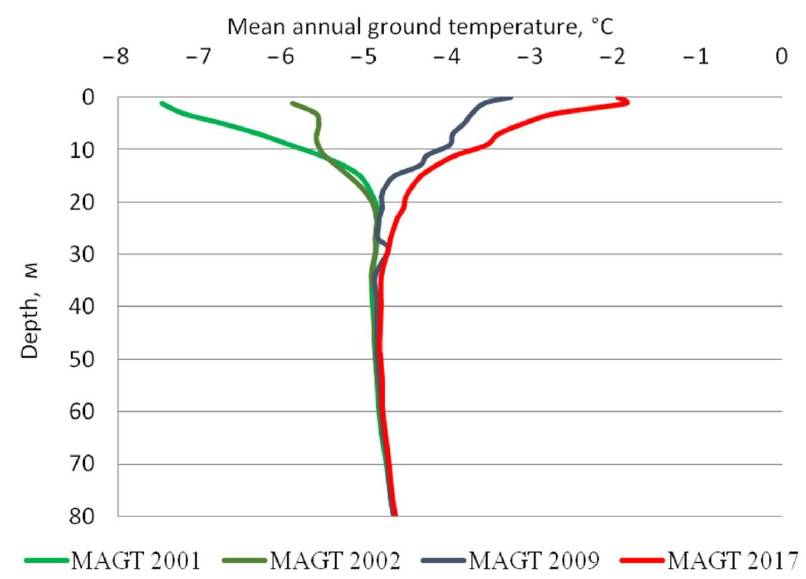
Figure 3. Mean annual ground temperature (MAGT) changes of permafrost in Western Yamal, borehole 1 – 95.